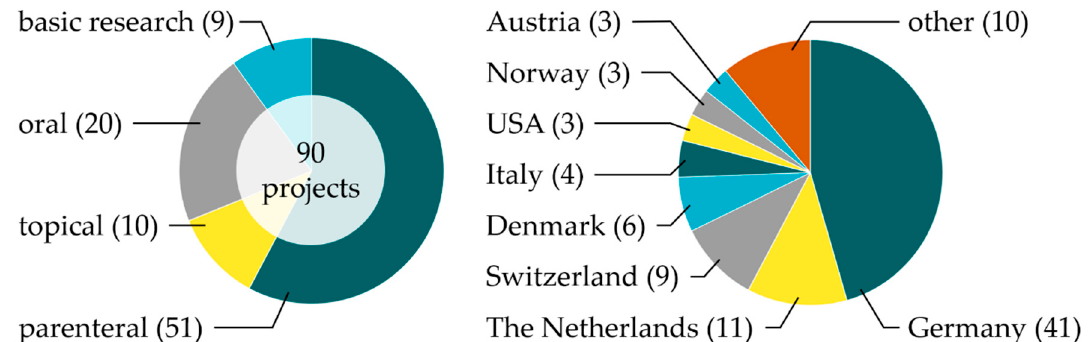
Figure 2. Distribution of the 90 research projects supported so far by the Phospholipids Research Center Heidelberg (PRC) regarding the phospholipids’ administration type / basic research ( left ) and location of projects across the world ( right ), with the number of projects in parentheses.